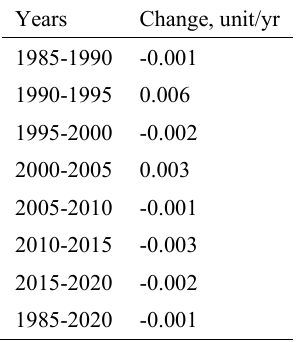
Table 2. NDVI changes, 1985 to 2020.